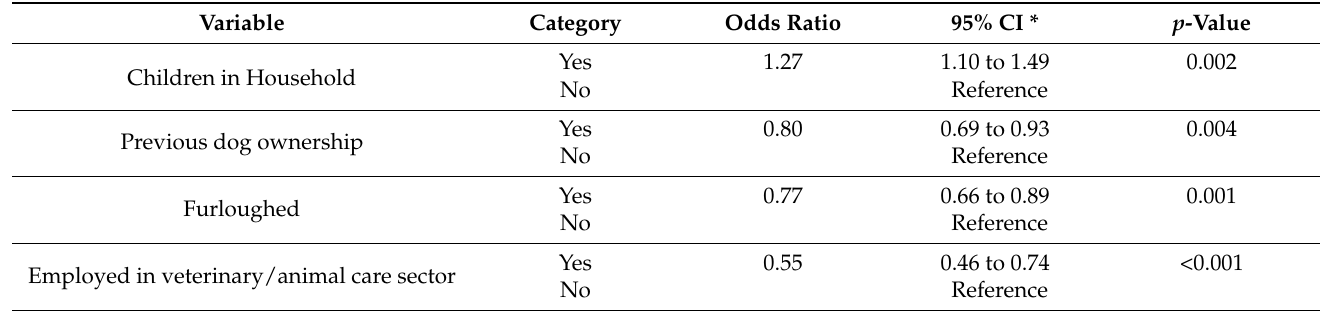
Table 1. Final multivariable model for owner demographic and lifestyle variables associated with purchasing a ‘Pandemic Puppy’ in the UK during 2020. * Confidence interval.